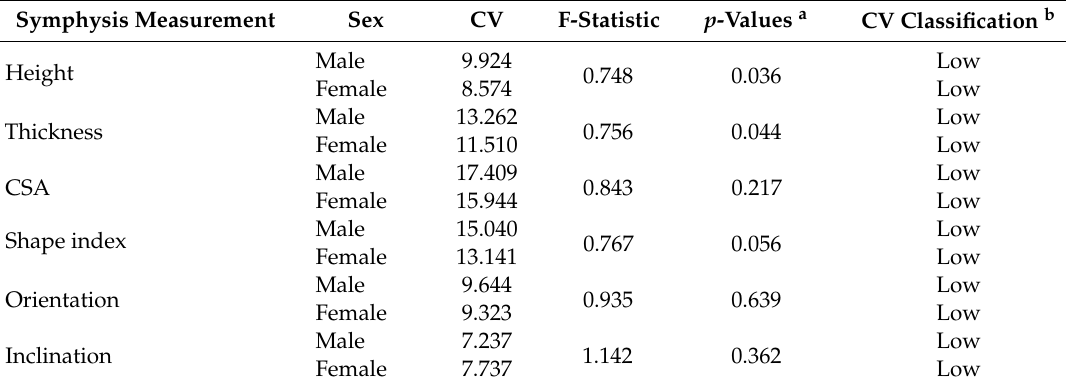
Table 7. Variation in symphysis morphometrics in males and females (males n = 203, females n = 216). Symphysis Measurement Sex CV F-Statistic p -Values a CV Classification